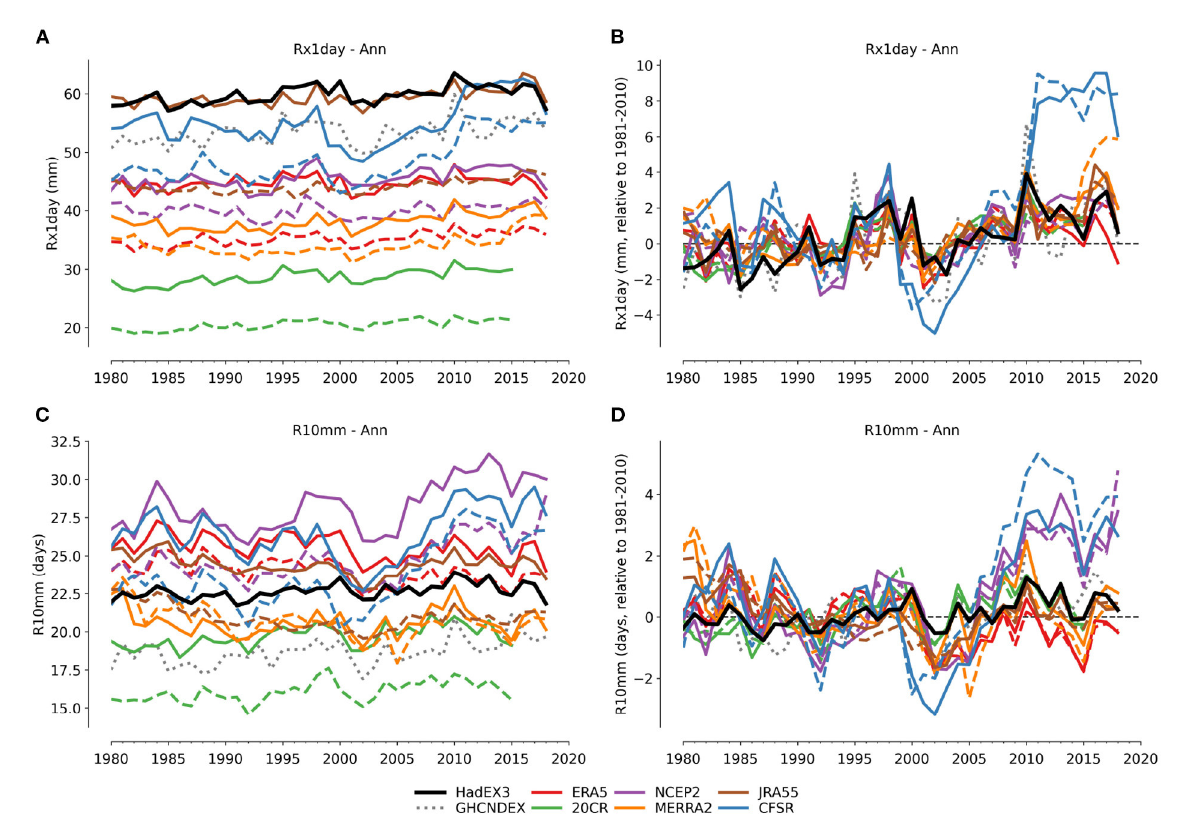
FIGURE6 Time series from absolute values (A,C) and anomalies (B,D) for Rx1day and R10mm. The dashed lines are for reanalyses using complete global land coverage, the solid ones are matched to the spatio-temporal coverage of HadEX3.